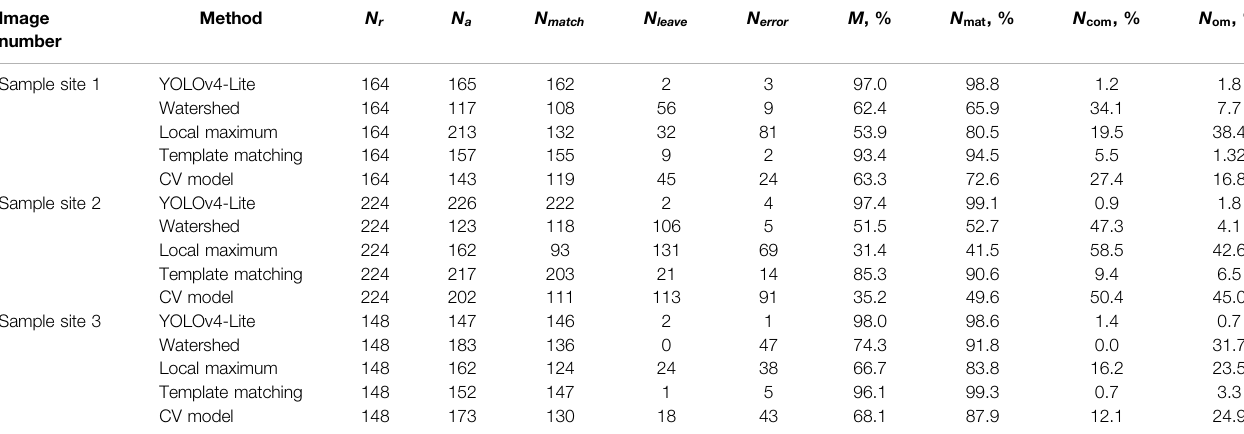
TABLE 7 | Sample site single-tree detection results ’ statistics. Image